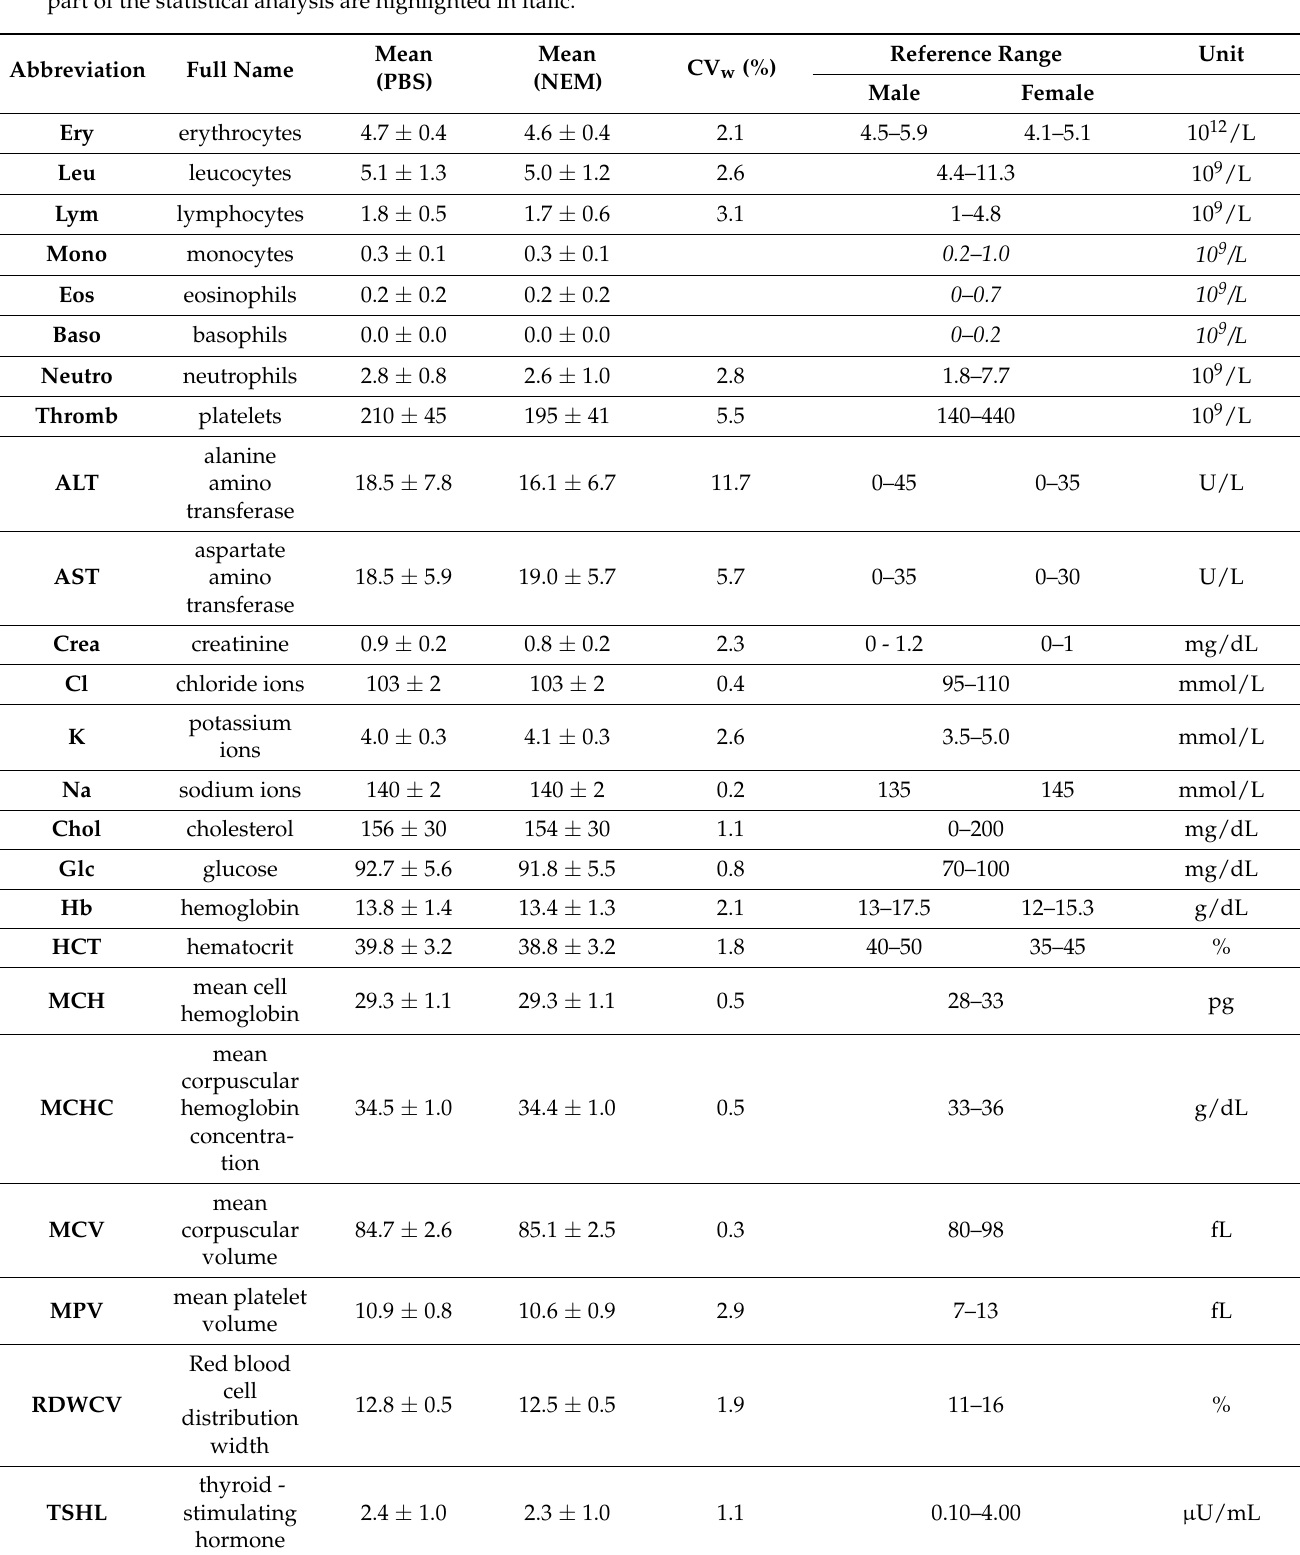
Table 2. Detailed list of blood parameters from blood with PBS or NEM addition (mean ± SD). CV w represents the mean of all standard deviations obtained per volunteer divided by the mean value of the given blood parameter. The transport occurred within 2.5 h after phlebotomy, and hematology measurement was performed within 4 h. Parameters that were not part of the statistical analysis are highlighted in